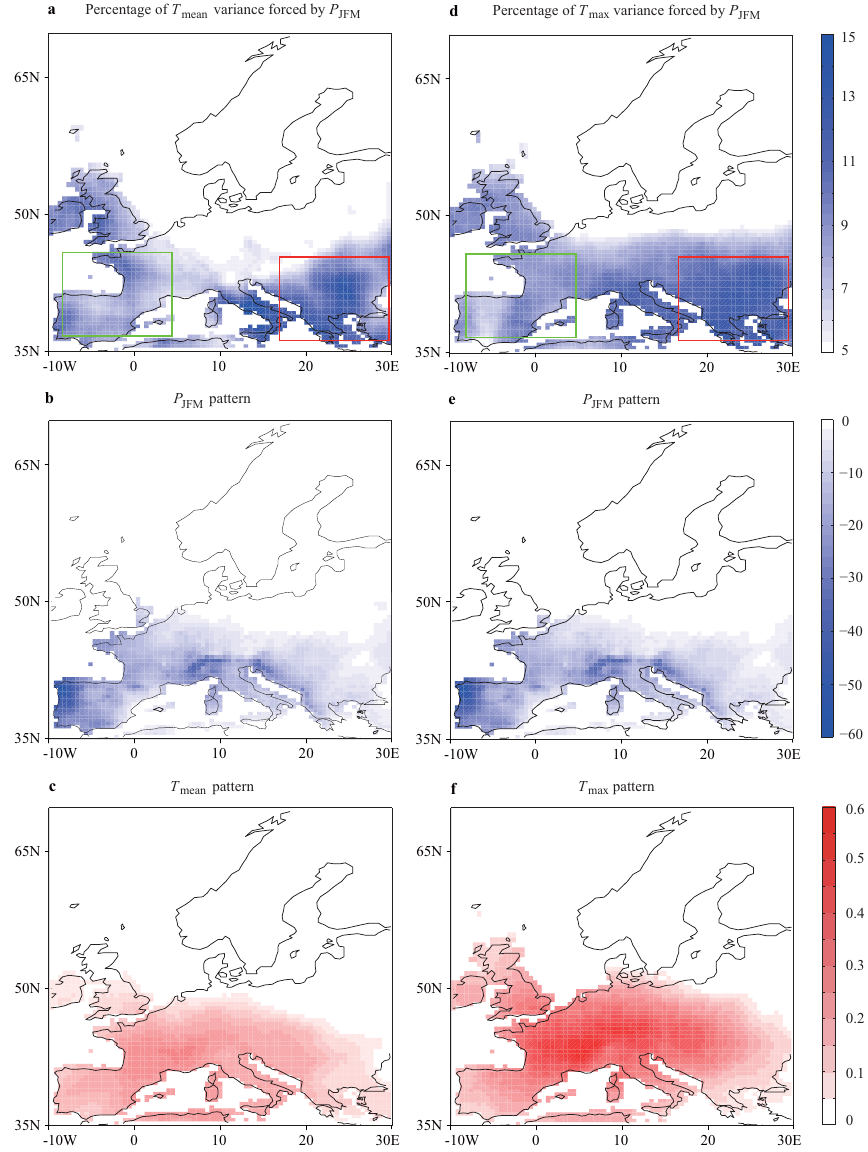
Fig. 1. T mean as well as T max variability forced by P JFM . (a) Percentage of T mean variance forced by P JFM (sig=0.10 in the red rectangle). The spatial patterns of (b) P JFM and (c) its T mean response. (d) Percentage of T max variance forced by P JFM (sig=0.10 in the red rectangle). The spatial patterns of (e) P JFM and (f) its T max response for the 1st MCA mode. All the relevant time coefficient series mutually exhibit unit correlation ( r > 0.99), shown in Fig 3. Units are K for T mean as well as T max and mm for P JFM